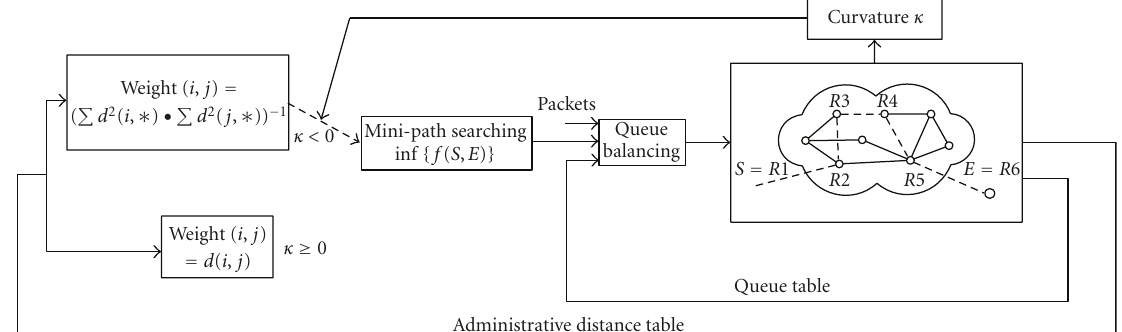
Figure 24: System-level diagram of curvature-based load